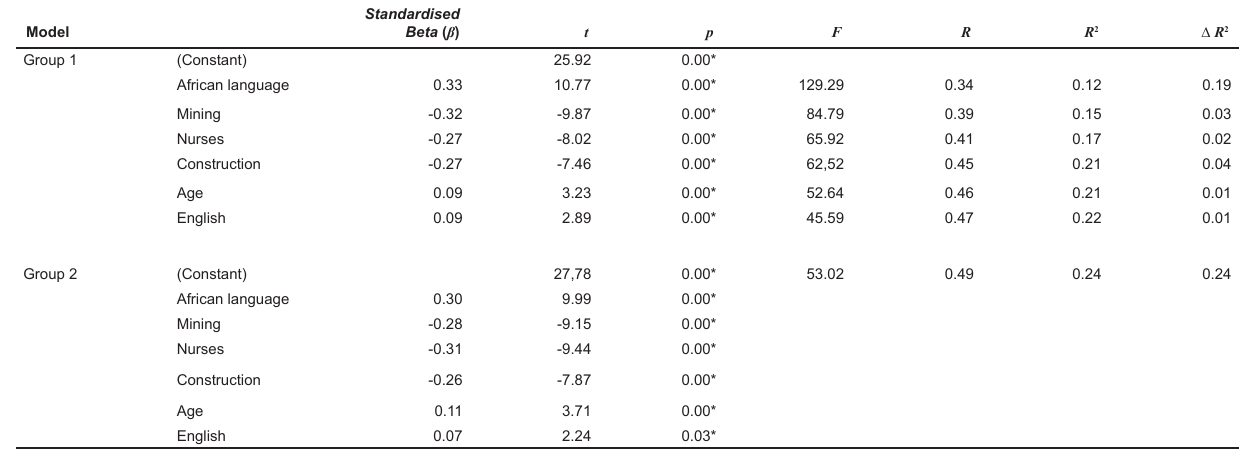
TABLE 3 Multiple regression analysis with positive WHI as dependent